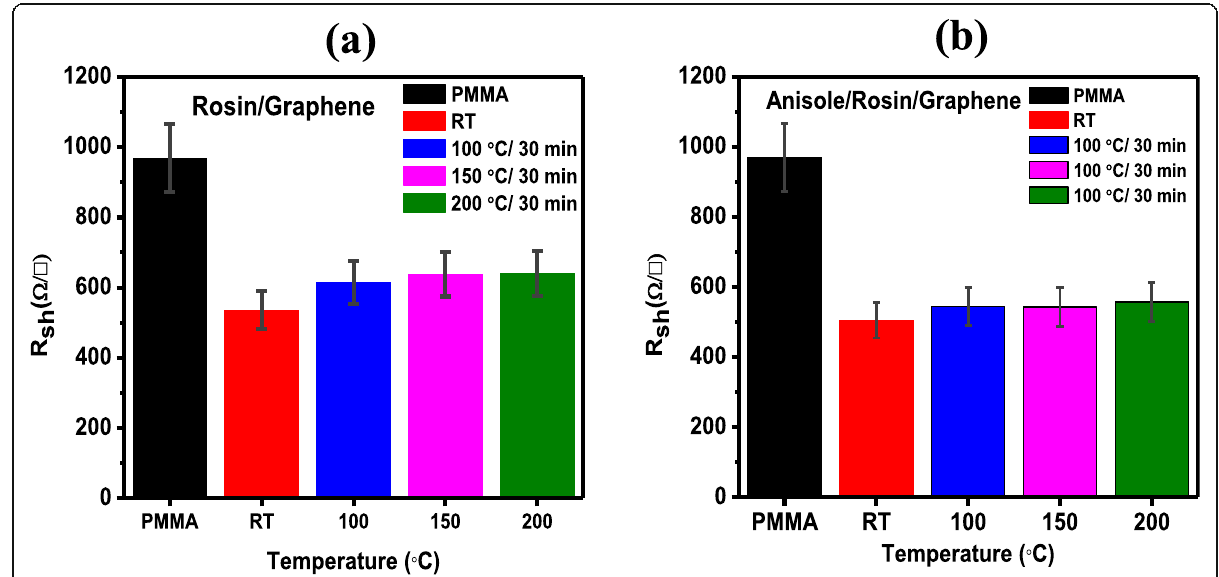
Fig. 9 a Average value of the sheet resistance measurement of rosin-enabled transfer process. b Average values of the sheet resistance of improved rosin-enabled transfer process with the minimum sheet resistance value of 493.4 Ω / □ at